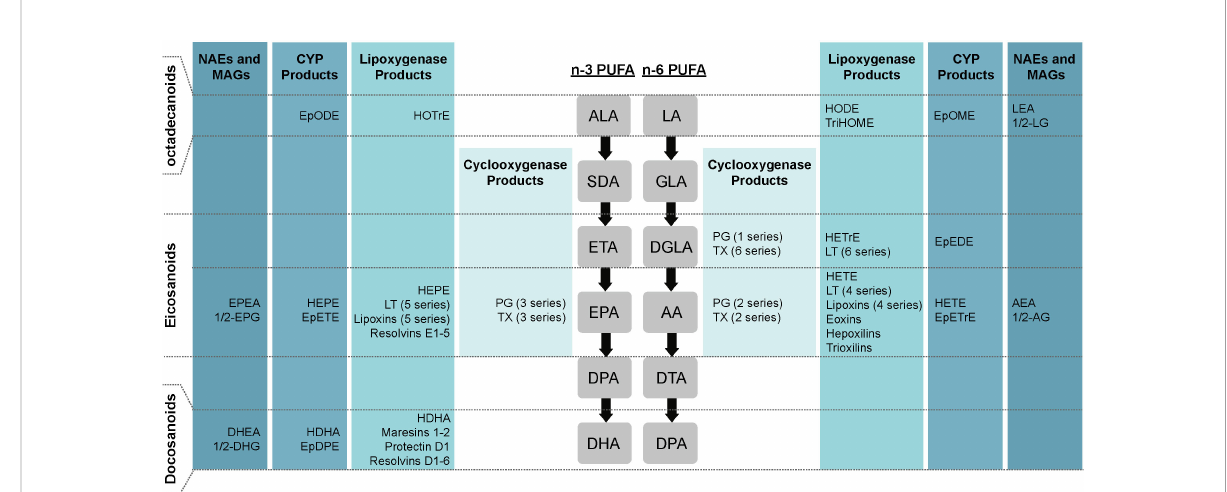
FIGURE 2 Schematic representation of different types of lipid mediators. Lipid mediators derived from ALA, EPA, DHA, LA, DGLA and AA. AA, arachidonic acid; ALA, alpha-linolenic acid; CYP, P450 cytochrome; DGLA, dihomo-gamma-linolenic acid; DHA, docosahexaenoic acid; DPA, docosapentaenoic acid; DTA, docosatetraenoic acid; EPA, eicosapentaenoic acid; EpDPE, epoxy-docosapentaenoic acid; EpEDE, epoxy- eicosadienoic acid; EpETE, epoxy-ecosatetraenoic acid; EpETrE, epoxy-eicosatrienoic acid; EpODE, epoxy-octadecadienoic acid; EpOME, epoxy-octadecenoic acid; ETA, eicosatetraenoic acid; GLA, gamma-linolenic acid; HDoHE, hydroxy-docosahexaenoic acid; HDHA, hydroxy- docosahexaenoic acid; HEPE, hydroxy-eicosapentaenoic acid; HETE, hydroxy-eicosatetraenoic acid; HETrE, hydroxy-eicosatrienoic acid; HODE, hydroxy-octadecadienoic acid; HOTrE, hydroxy-octadecatrienoic acid; LA, linoleic acid; SDA, stearidonic acid; TriHOME, trihydroxy- octadecenoic acid, PG, prostaglandin; LT, leukotriene; TX,